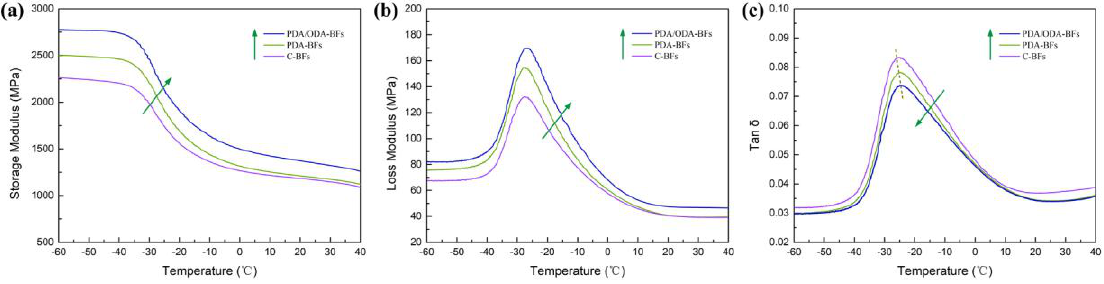
Figure 5. DMA curves of PBS composites: ( a ) storage modulus; ( b ) loss modulus; and ( c ) loss factor (tan δ ).